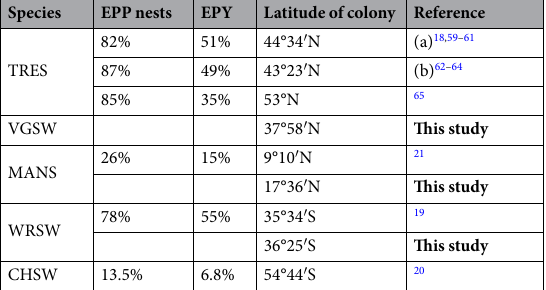
Table 4. Rates of extra-pair paternity for four Tachycineta species taken from the literature, with the latitudes of all populations sampled. EPP nests: % of nests with extra-pair young. EPY: % of extra-pair nestlings in the population. TRES = Tree swallow, VGSW = Violet-green swallow, MANS = Mangrove swallow, WRSW = White-rumped swallow, CHSW = Chilean swallow. (a) We calculated the averages for this population using the results reported on these four studies; (b) We calculated the averages for this population using the results reported on these three